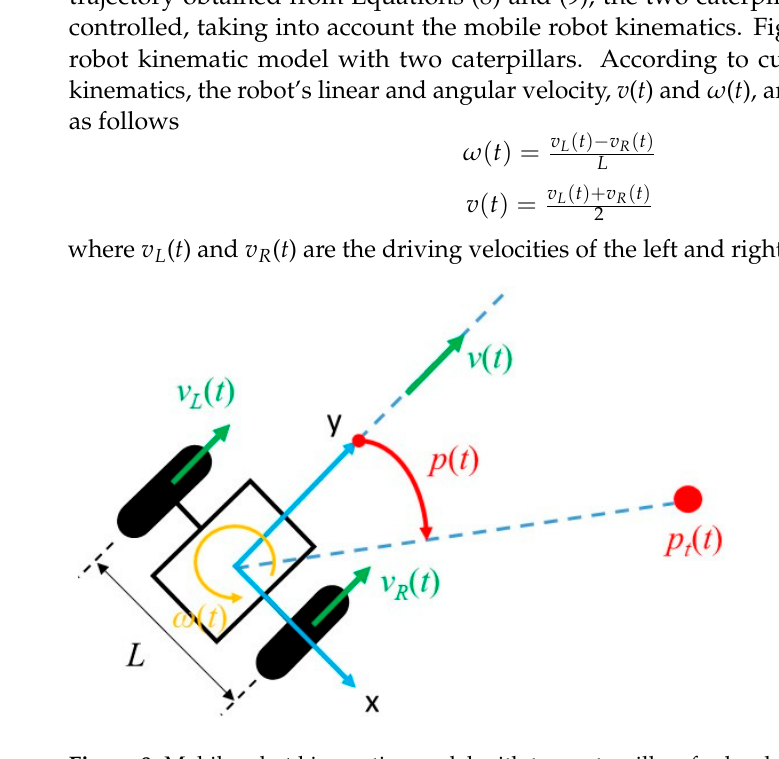
Figure 8. Mobile robot kinematics model with two caterpillars for local coordinates ( x , y ).